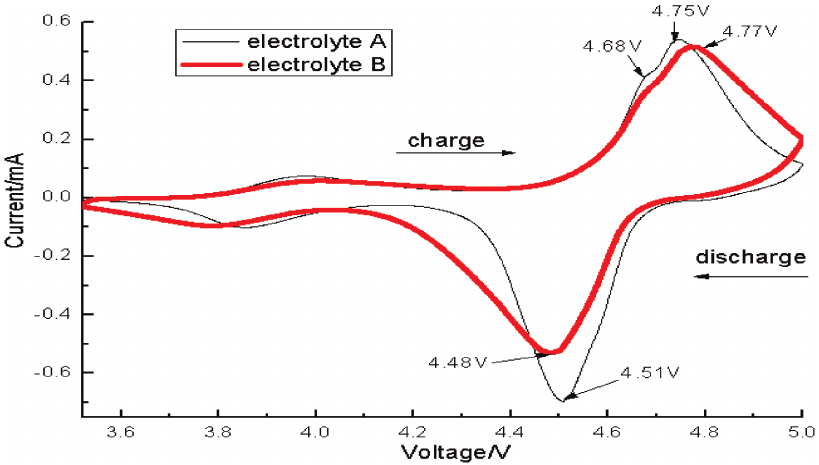
Fig. 6: Cyclic voltammetry of LiNi 0.5 Mn 1.5 O 4 coin cells with two different kinds of electrolyte in 3.5–5.0V rang at scan of 0.1 mV·s −